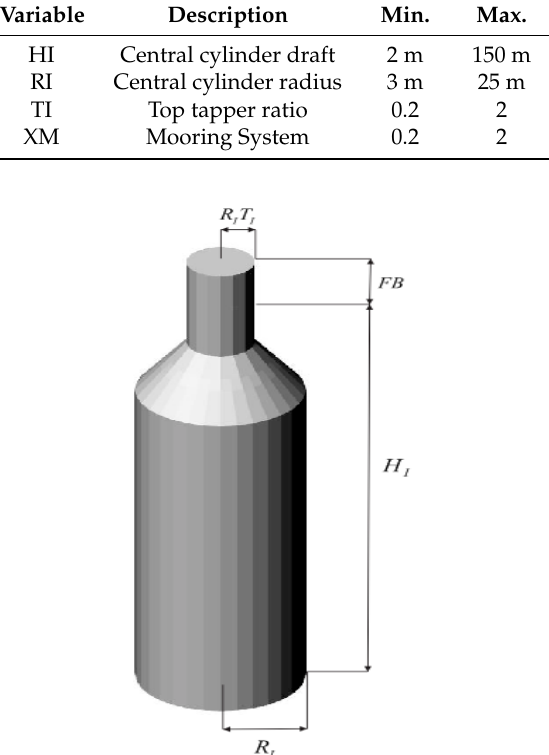
Figure 15. Design characteristics of a spar buoy platform including height, radius, and taper ratio of the cylinder as well as platform’s free board. Table 6. Geometric design variables of spar buoy platform.